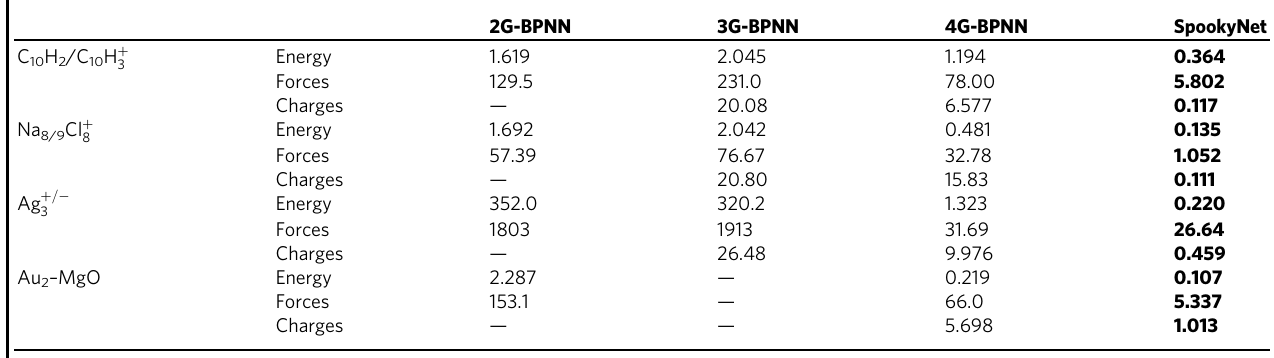
Table 1 Root mean square errors (RMSEs) of energies (meV/atom), forces (meV Å − 1 ) and charges (me) for the datasets introduced in ref. 49 .